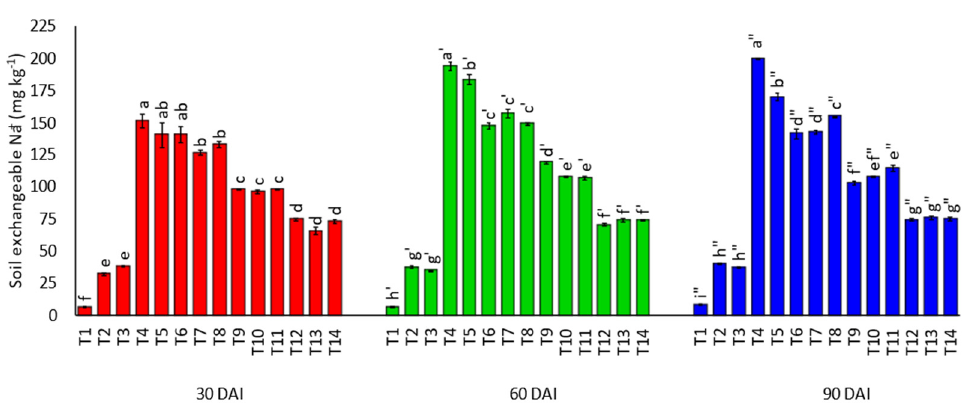
Figure 12. Effects of treatments on soil exchangeable sodium ions after thirty, sixty, and ninety days of incubation, where T1: soil alone, T2: Egypt rock phosphate alone, T3: Egypt rock phosphate + 100% charcoal, T4: Egypt rock phosphate + 100% sago bark ash, and T5: Egypt rock phosphate + 100% charcoal + 100% sago bark ash, T6: Egypt rock phosphate + 75% charcoal + 75% sago bark ash, T7: Egypt rock phosphate + 50% charcoal + 75% sago bark ash, T8: Egypt rock phosphate + 25% charcoal + 75% sago bark ash, T9: Egypt rock phosphate + 75% charcoal + 50% sago bark ash, T10: Egypt rock phosphate + 50% charcoal + 50% sago bark ash, T11: Egypt rock phosphate + 25% charcoal + 50% sago bark ash, T12: Egypt rock phosphate + 75% charcoal + 25% sago bark ash, T13: Egypt rock phosphate + 50% charcoal + 25% sago bark ash, and T14: Egypt rock phosphate + 25% charcoal + 25% sago bark ash.. Means with different letter(s) within the same incubation period indicate significant differences between treatments according to Tukey’s HSD test at p ≤ 0.05, i.e., a > b > c. Bars represent the mean values ± SE.